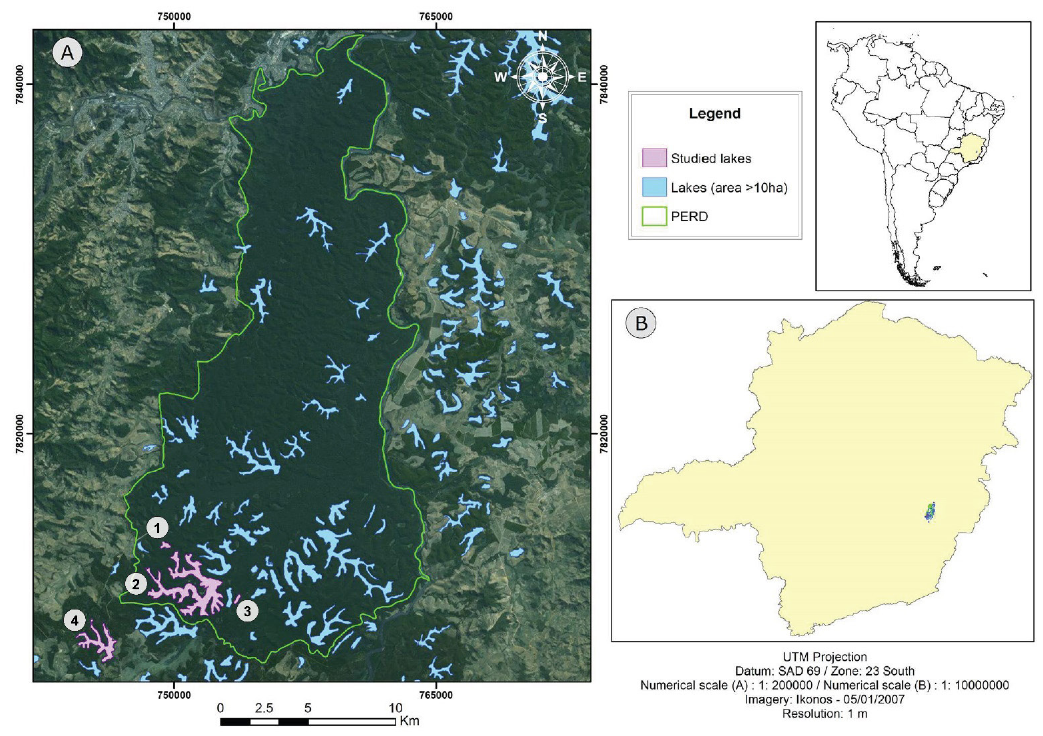
Figure 1. The spatial location of study area. (A) The Rio Doce State Park (PERD) and its surroundings. The lakes of the region with an area greater than 10 ha are represented in blue (n purple. They are numbered as (1) Carioca Lake; (2) Dom Helvécio Lake; (3) Gambazinho Lake; and (4) Jacaré Lake; (B) The location of our study site in the SE portion of the Minas Gerais